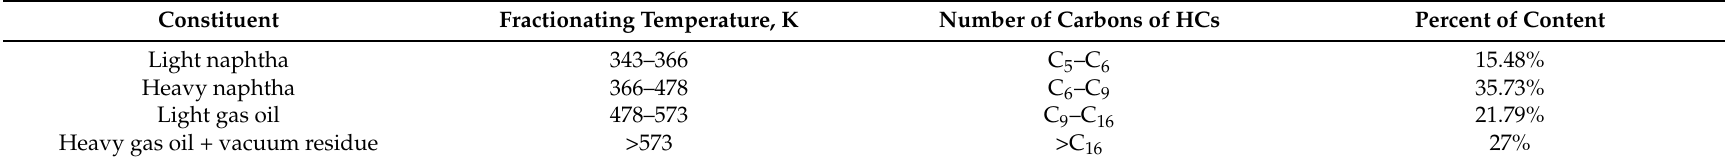
Table 5. Fuel contents of BFO obtained from treating JO via HTC at T C = 683 K, t r = 60 min and P H2 = 0.69 MPa (100 psig). HCs: hydrocarbons.